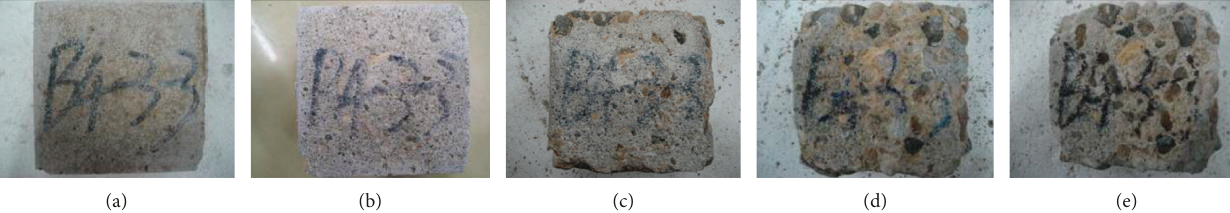
Figure 7: Surface damage characteristics of specimens exposed to drying-wetting cycles with sulfate attack. (a) 0 days, (b) 21 days, (c) 42 days, (d) 54 days, and (e) 63